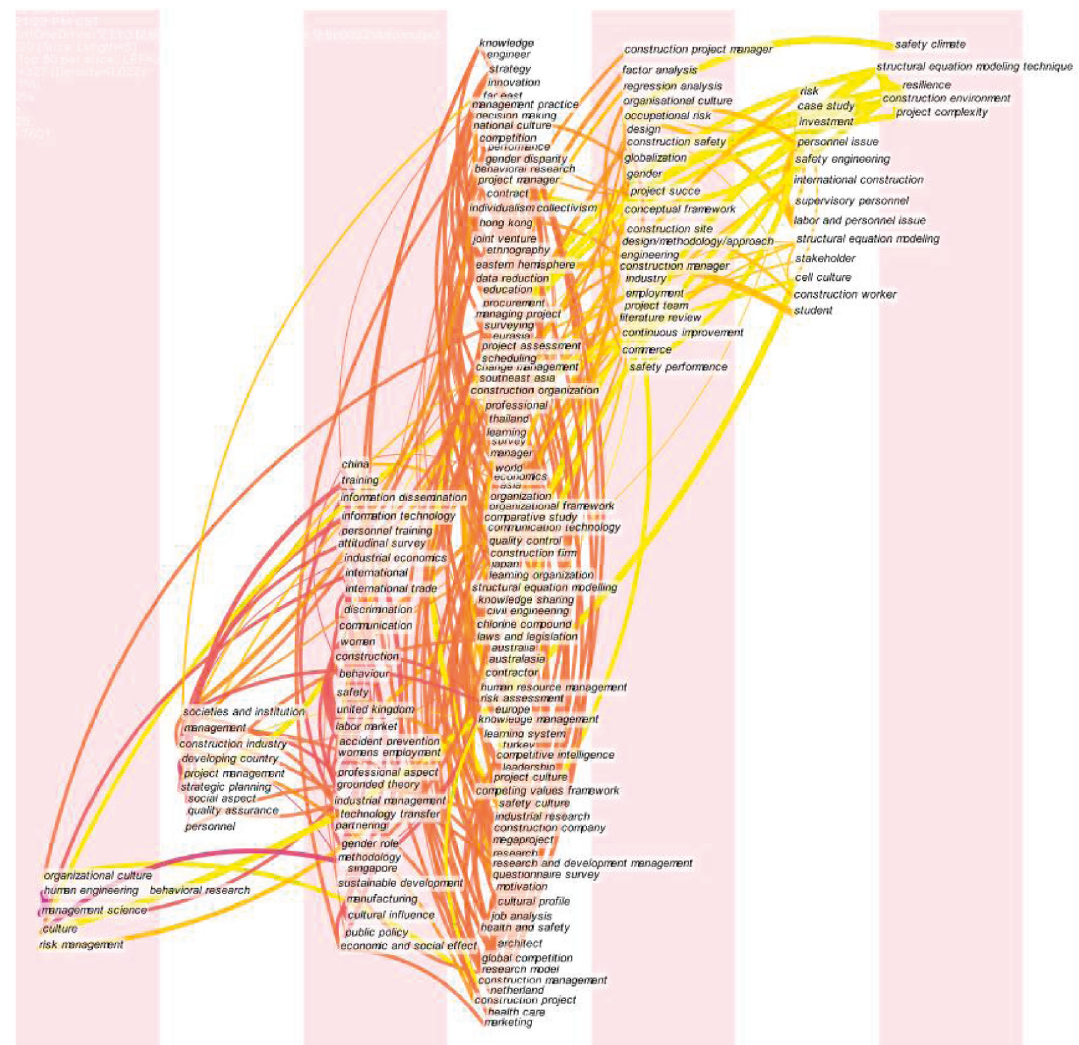
Figure 7: A timezone view of keywords occurring more than twice: